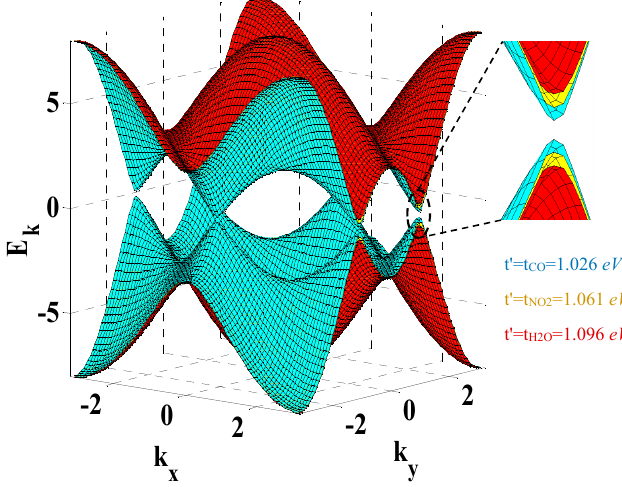
Figure 4. Graphene energy bandgap variation after target molecule adsorption.